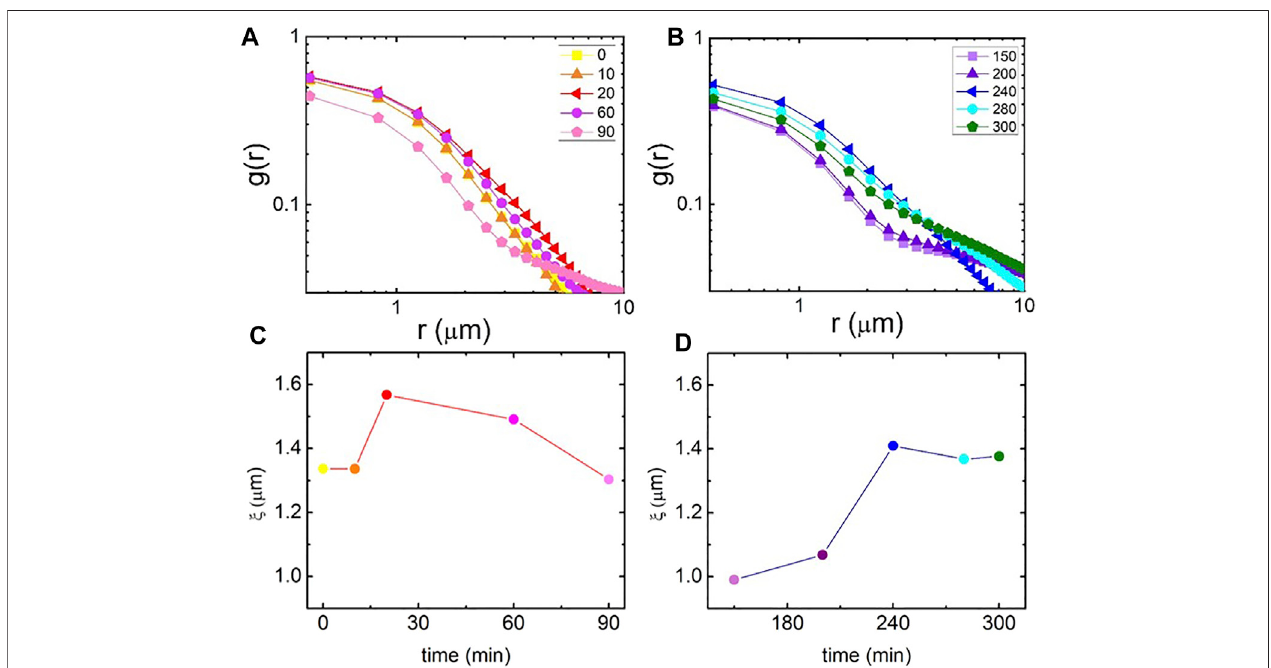
FIGURE 4 | Spatial image autocorrelation analysis quanti fi es the salt-mediated structural changes to actomyosin networks that give rise to the time-varying viscoelastic properties. (A, B) Spatial image autocorrelation functions g ( r ) versus distance r computed from confocal images shown in Figure 3 . Plots are divided into “ high-salt ” (A) and “ low-salt ” (B) conditions with the experimental time (in min) of each image listed in the legend. (C, D) Structural correlation lengths ξ determined from fi tting each g ( r ) shown in (A) and (B) to an exponential decay function g ( r ) ∼ e − r / ξ . ξ , which indicates the average size of structural features, shows bundling (increasing ξ ) and subsequent destruction (drop in ξ ) during the high-salt period (C) , followed by re-assembly into highly-bundled networks during the low-salt period [ (D) , increase in ξ to value larger than t (cid:1) 0 value].